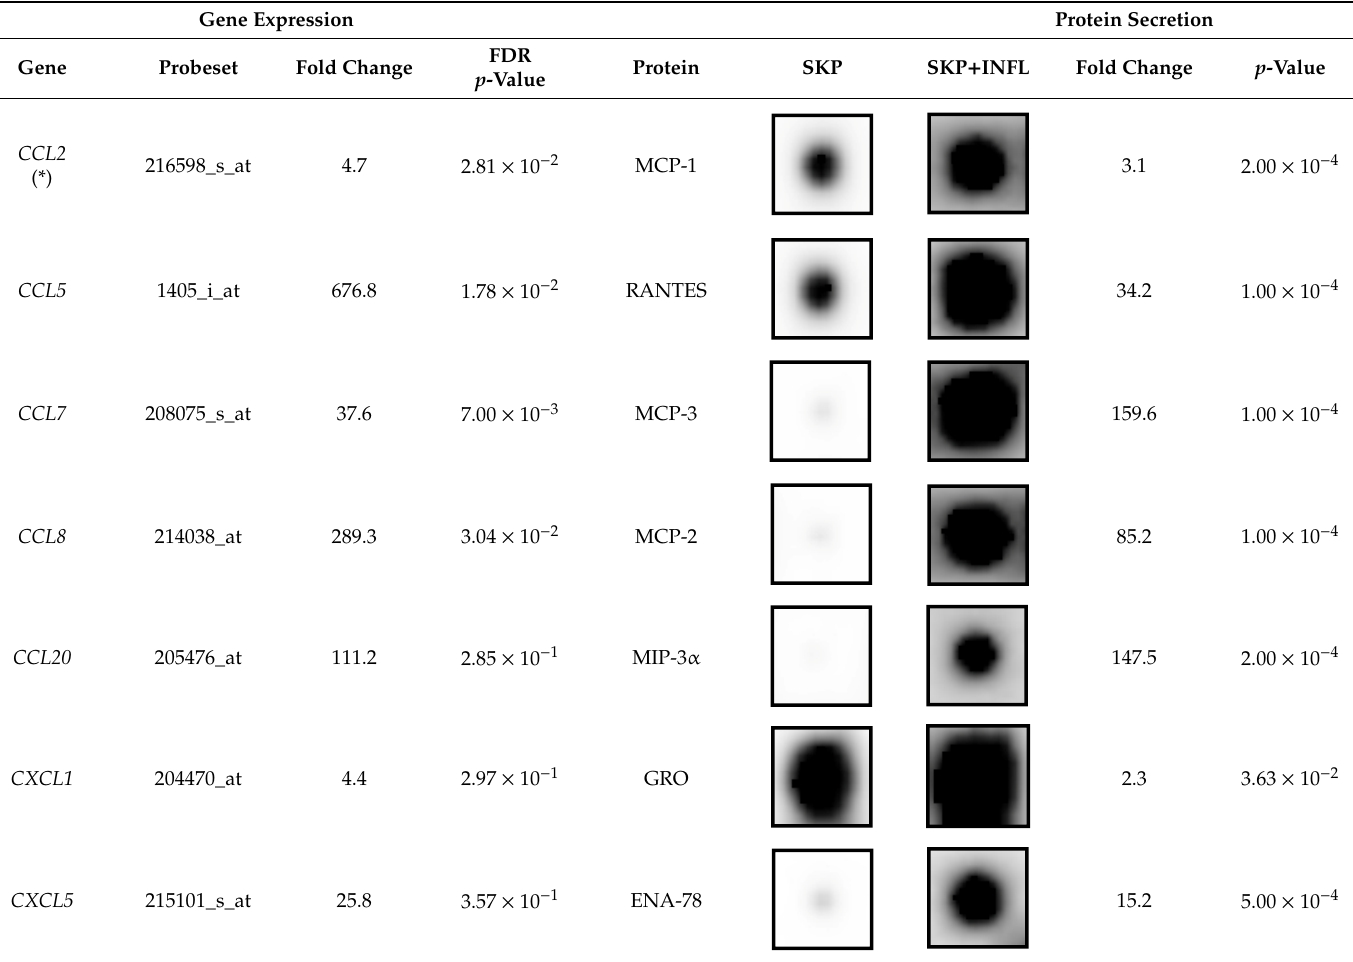
Table 1. Secretome of SKP is Altered by Inflammation.